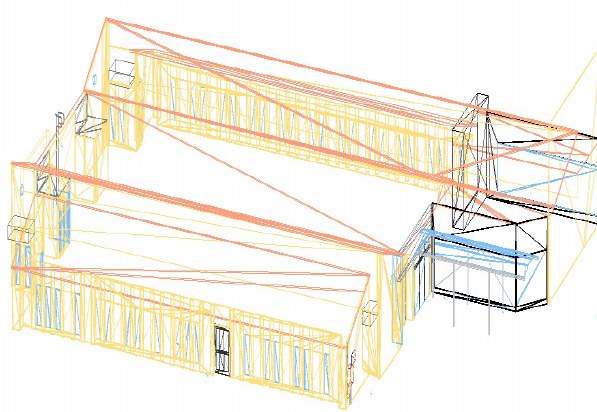
Figure 8: 3D visualisation of segmented building structures in DXF.